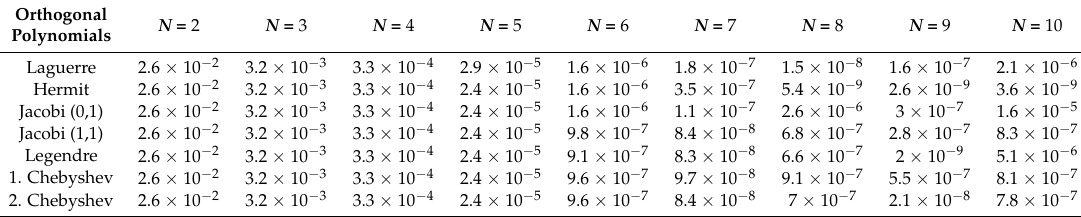
Table 4. Maximum error for Example 6 using the collocation point